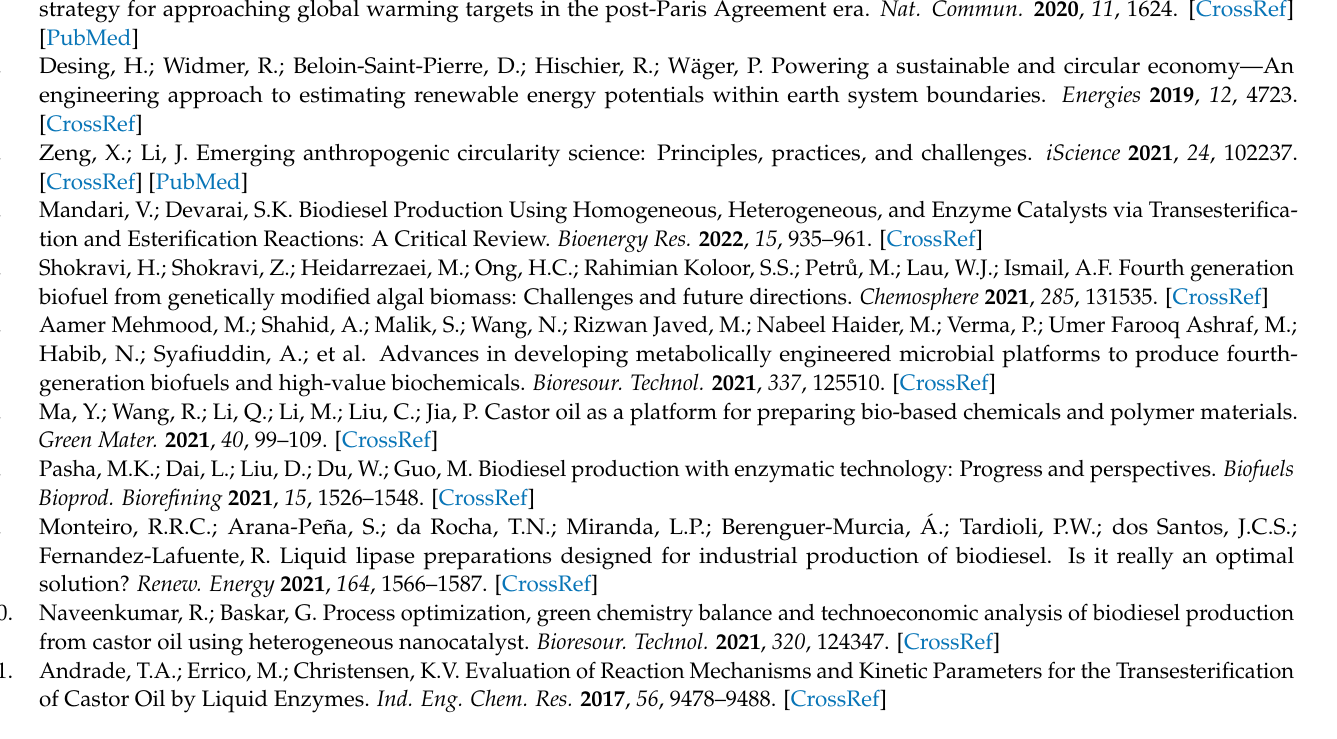
N435 at T = 60 ◦ C for the anhydrous system; Table S4. Experimental results of the enzymatic es- terification of glycerin with ibuprofen immobilized enzyme N435 at T = 70 ◦ C for the anhydrous system; Table S5. Experimental results of the enzymatic esterification of glycerin with ibuprofen immobilized enzyme N435 at T = 80 ◦ C for the anhydrous system; Table S6. Kinetic runs performed for the hydrated triphasic system; Table S7. Experimental results of the enzymatic esterification of glycerin with ibuprofen immobilized enzyme N435 at T = 50 ◦ C for the system with added water; Table S8. Experimental results of the enzymatic esterification of glycerin with ibuprofen immobilized enzyme N435 at T = 60 ◦ C for the system with added water; Table S9. Experimental results of the enzymatic esterification of glycerin with ibuprofen immobilized enzyme N435 at T = 70 ◦ C for the system with added water; Table S10. Experimental results of the enzymatic esterification of glycerin with ibuprofen immobilized enzyme N435 at T = 80 ◦ C for the system with added water. Author Contributions: Conceptualization, M.L. and M.E.G.; data curation, A.G.-C. and M.L.;